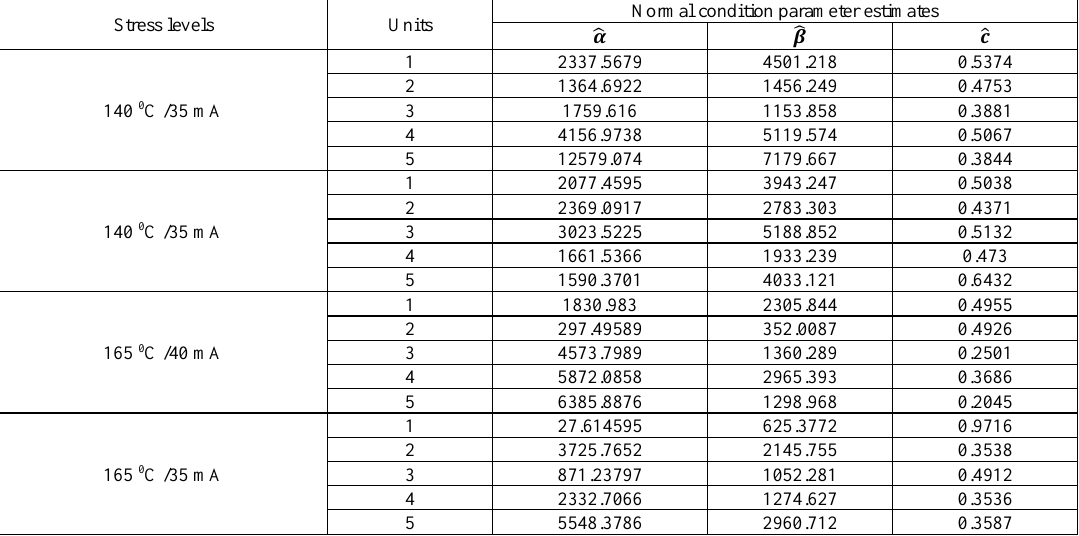
Table 4. Converted parameter estimates of sample units at normal operating conditions.